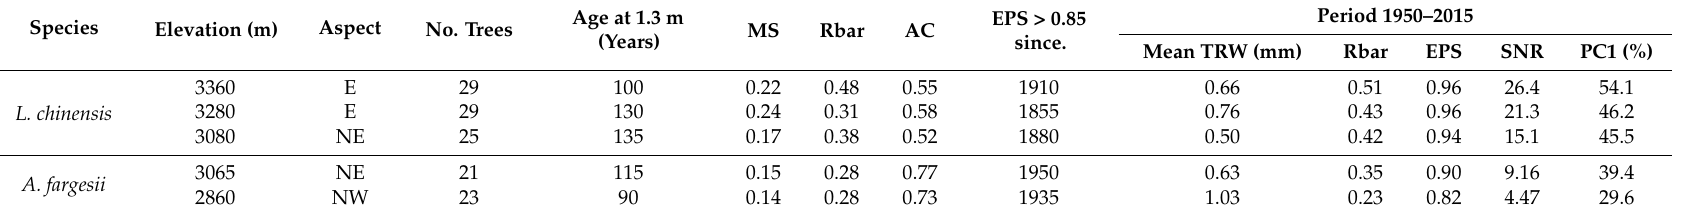
Table 1. Site information and dendrochronological statistics of the standard tree-ring width